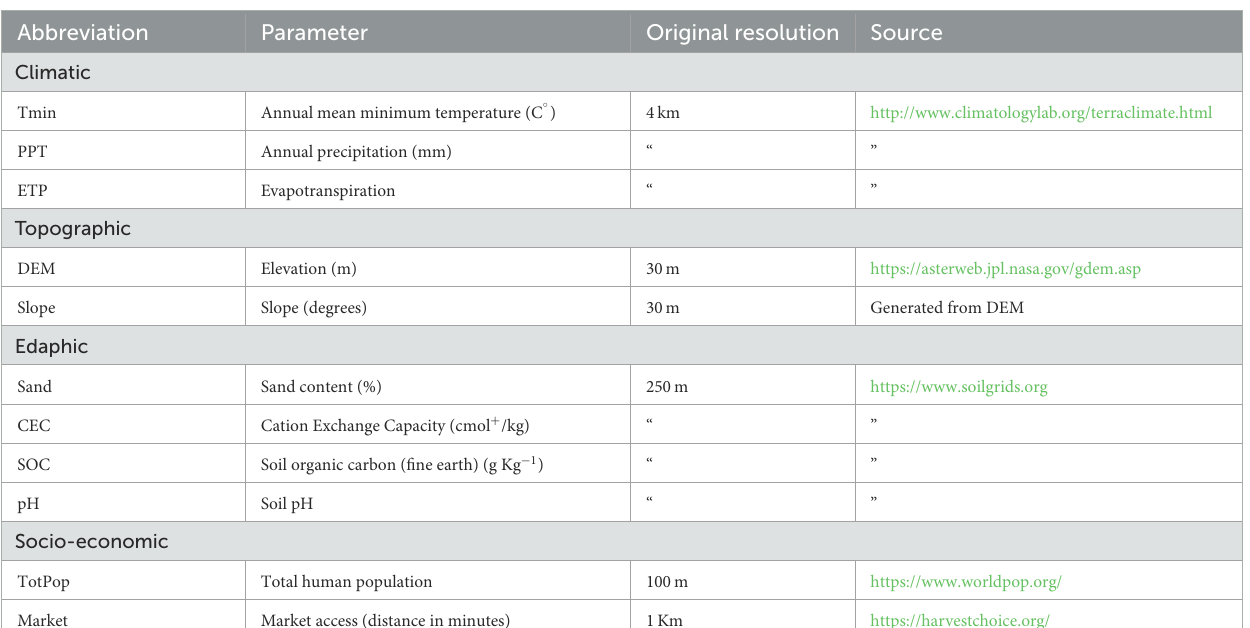
TABLE 1 Input variables for delineating extrapolation suitability index for vegetable